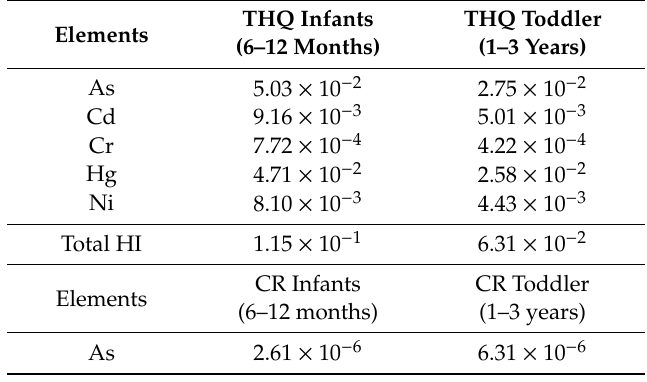
Table 4. Target Hazard Quotient (THQ) and Cancer Risk (CR) calculated for Infants and Toddlers.